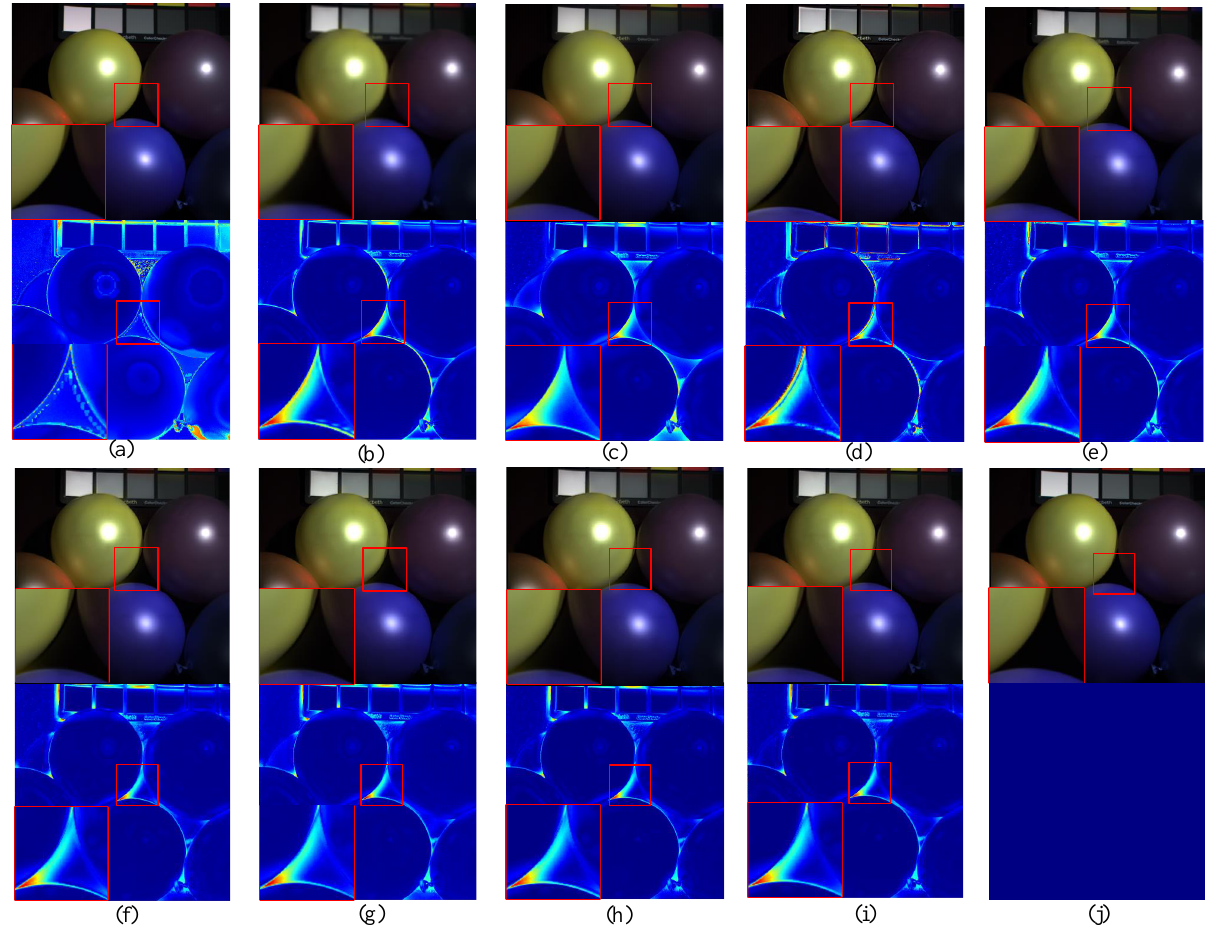
Figure 5. The visual results of different methods on the CAVE dataset. ( a ) CNMF; ( b ) Bayesian naive; ( c ) GFPCA; ( d ) PanNet; ( e ) DDLPS; ( f ) Original RCAM; ( g ) Original MSRNet; ( h ) S 1 (RCAM) in the SSML framework; (i) S 2 (MSRNet) in the SSML framework; ( j ) Ground truth. Note that the false color image is selected for clear visualization (red: 30, green: 20, and blue: 10). The even rows show the difference maps of the corresponding